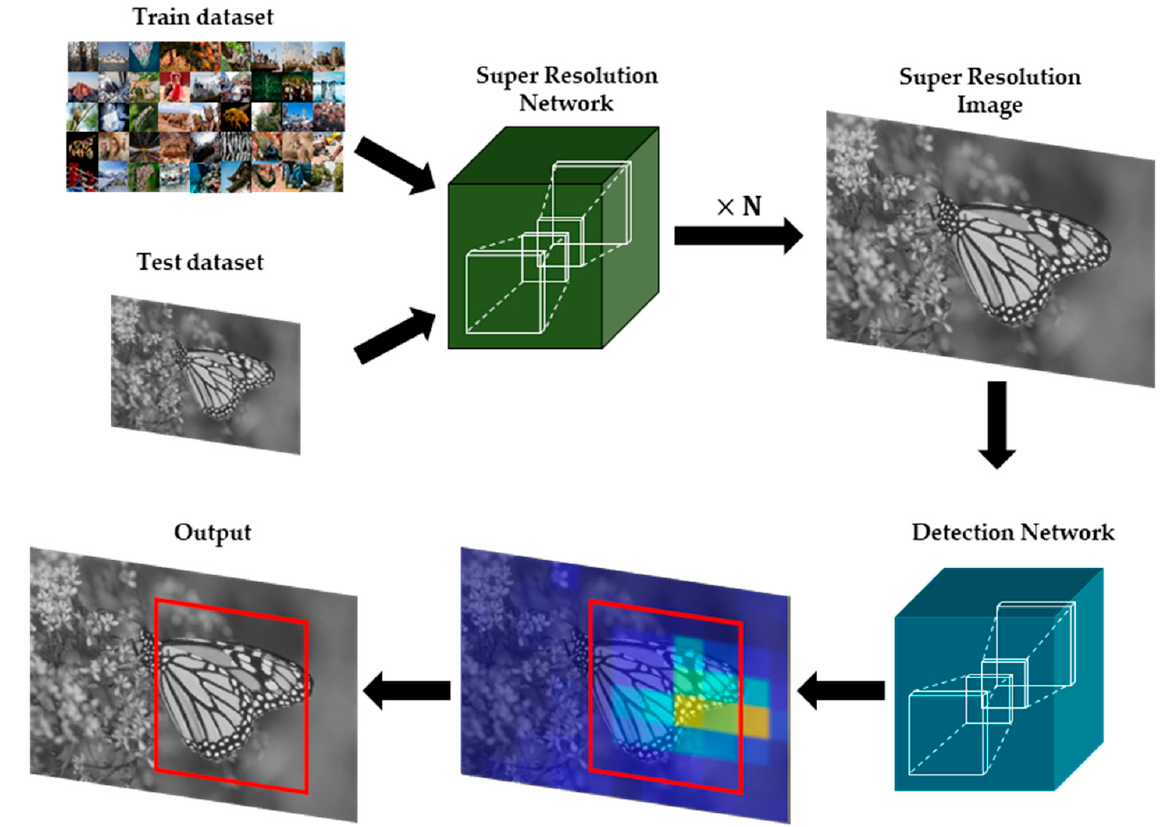
Figure 1. Example of CNN-based SR applications in the area of object detection. As shown in Figure 2, the inception block [15] was designed to obtain the sparse feature maps by adjusting the different kernel sizes. He et al. [16] proposed a ResNet using the residual block, which learns residual features with skip connections. It should be noted that CNN models with the residual block can support high-speed training and avoid the gradient vanishing effects. In addition, Huang et al. [17] proposed densely connected con- volutional networks (DenseNet) with the concept of dense block that combines hierarchical feature maps along the convolution layers for the purpose of richer feature representations. As the feature maps of the previous convolution layer are concatenated with those of the current convolution layer within a dense block, it requires more memory capacity to store massive feature maps and network parameters. In this paper, we propose a lightweight CNN-based SR model to reduce the memory capacity as well as the network